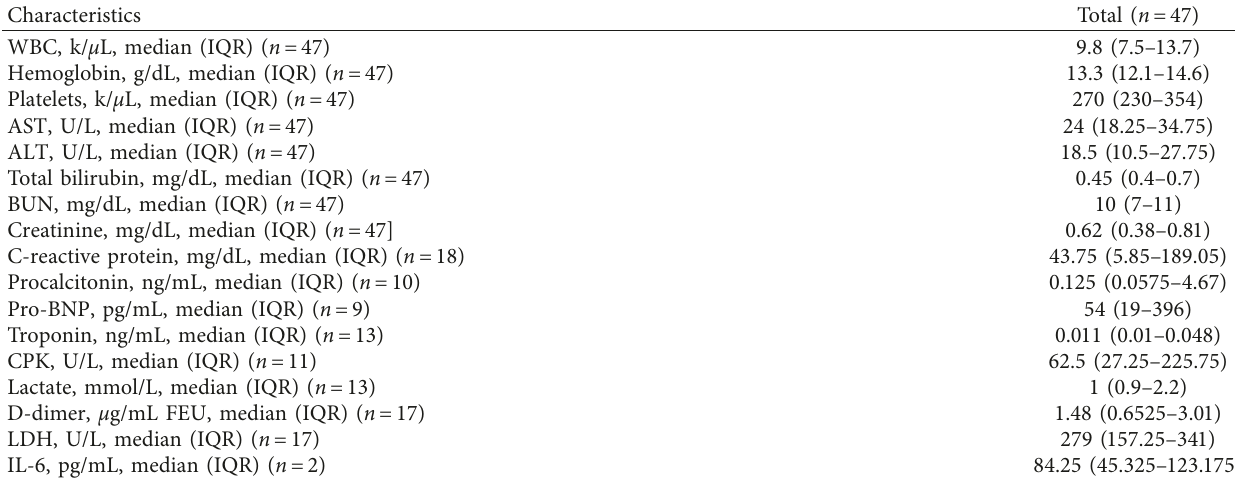
Table 3: Selected laboratory characteristics of hospitalized patients.